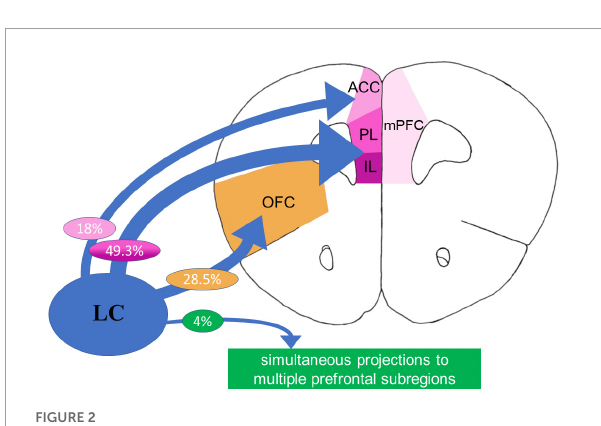
FIGURE2 The rodent prefrontal cortex (PFC) receives dense projections from the locus coeruleus (LC). Subregions of the rat medial prefrontal cortex (mPFC) receive dense innervation from the LC, with significantly higher amount of norepinephrine (NE) varicosities (Agster et al., 2013) and high percentage of LC projections to the prelimbic (PL)/infralimbic (IL) regions compared to other cortical regions, and relatively low (4%) overlap (Chandler et al.,